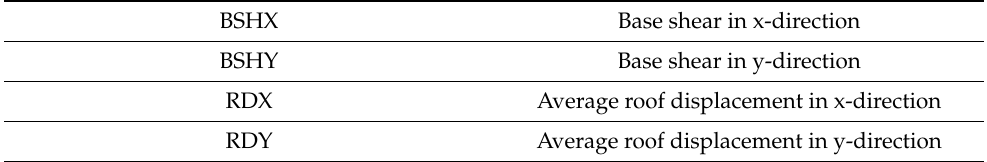
Table 3. List of seismic response parameters for which the maximum absolute values are